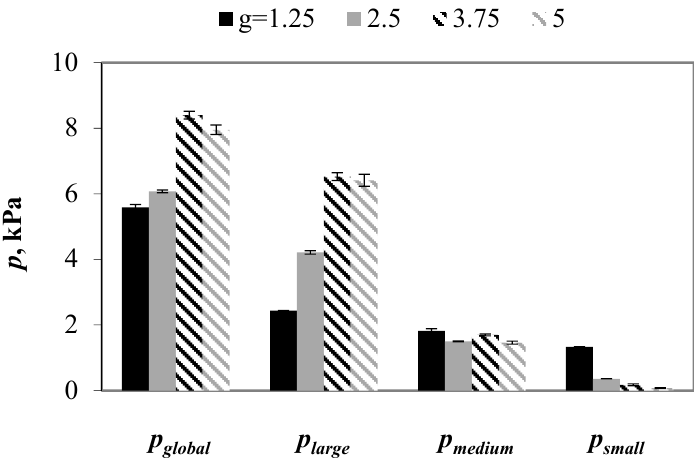
Figure 10. Global and partial stresses in mixtures with various values of g when subjected to a vertical load of 100 kPa.